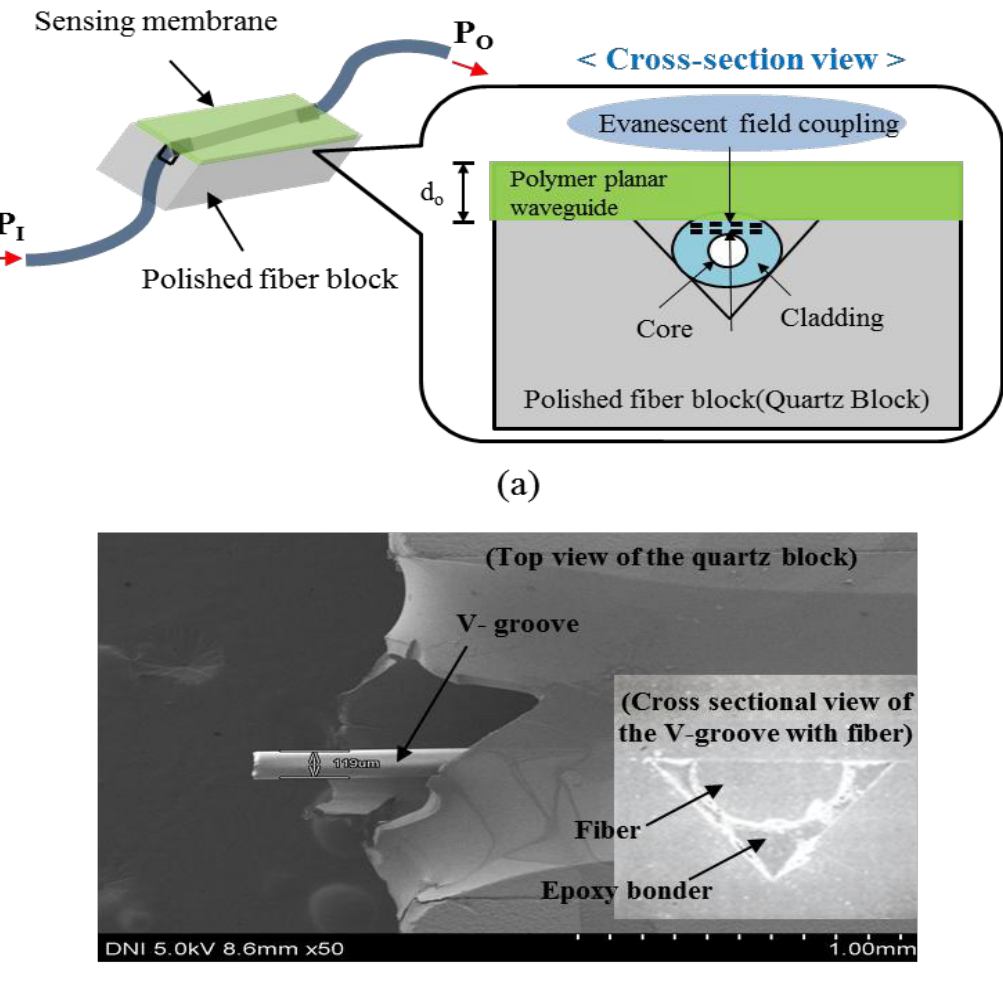
Figure 1. Side-polished optical-fiber device: ( a ) schematic diagram; and ( b ) SEM